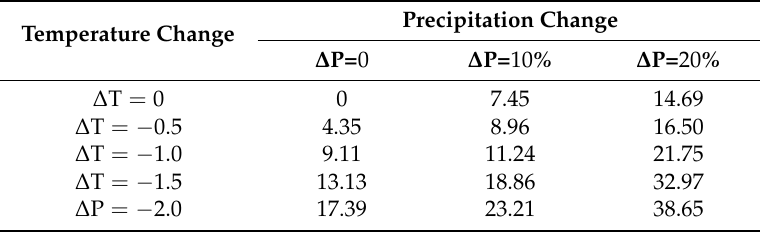
Table 9. Response of runoff to temperature reduction and precipitation increase.